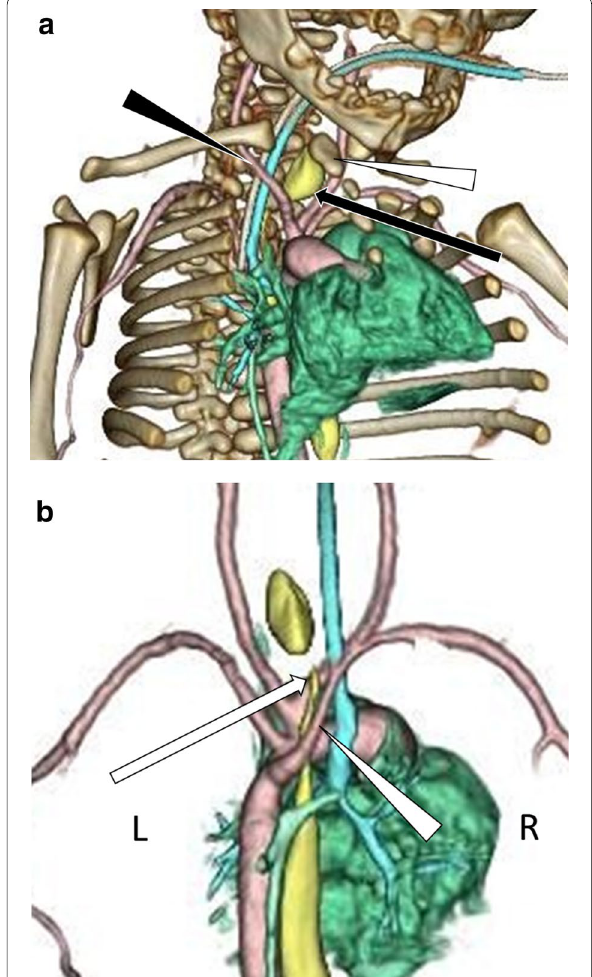
Fig. 1 Three-dimensional computed tomography. The trachea (light blue), esophagus (yellow), and blood vessels (pink) are shown. a Image from the front right. The upper pouch of the esophagus (black arrow) was located at the thoracic inlet and completely to the left of the trachea. The brachiocephalic artery is indicated by the black arrowhead and the manubrium of the sternum is indicated by the white arrowhead. b Image from the back. The TEF indicated by a white arrow, was connected to the trachea at the level of the lower end of the upper pouch of the esophagus. The aberrant right subclavian artery is indicated by a white